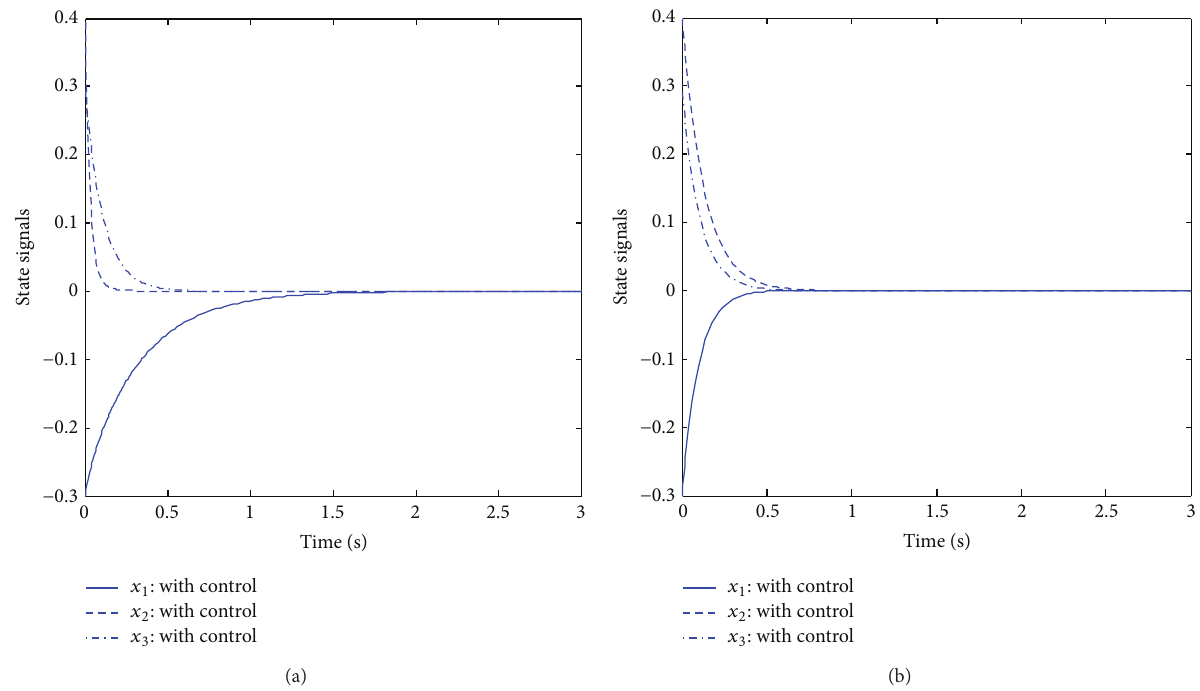
Figure 6: Transient response of state signals with (a) single input, single state, unit negative feedback 𝑢 2 = −8𝑥 2 ; (b) static state feedback = −5𝑥 𝑢 = −13𝑥 𝑢 = 0 𝑢 1 1 , 2 2 , and 3